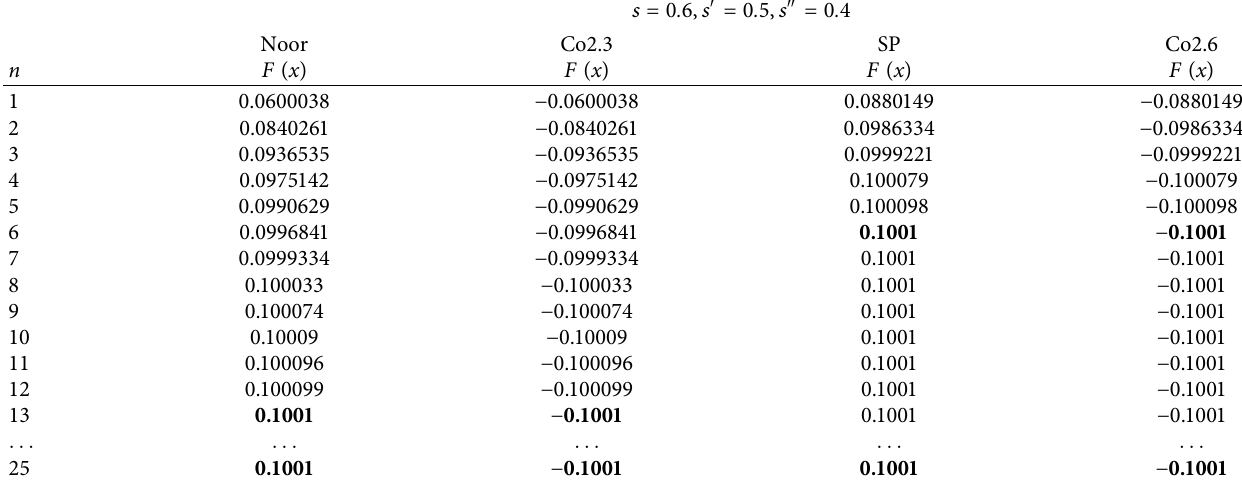
Table 7: Iterations of biquadratic function s � 0 . 6 ,s ′ � 0 . 5 ,s ″ � 0 . 4.